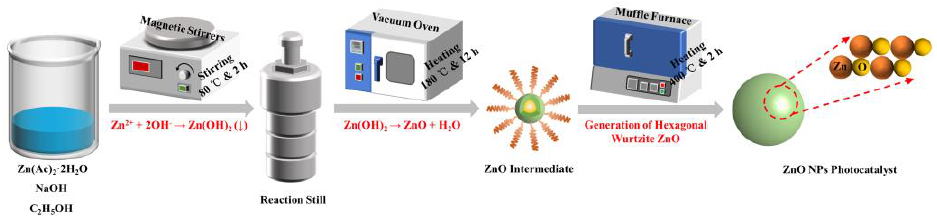
Figure 1. Preparation of ZnO NPs.